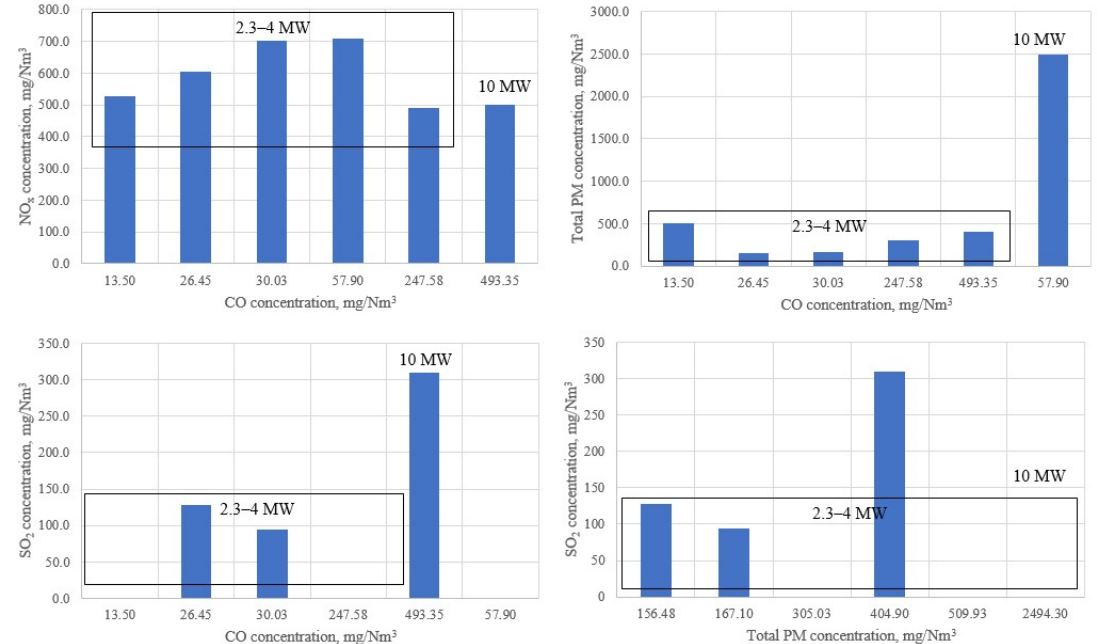
Figure 5. The concentrations of pollutants emitted at different shares of lignin in the burnt fuel under varying power of the boiler in combustion